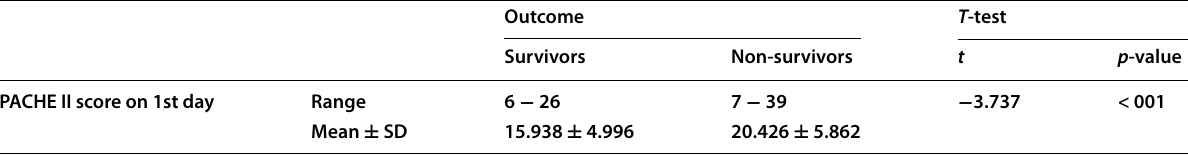
APACHE II Acute Physiology and Chronic Health Evaluation II